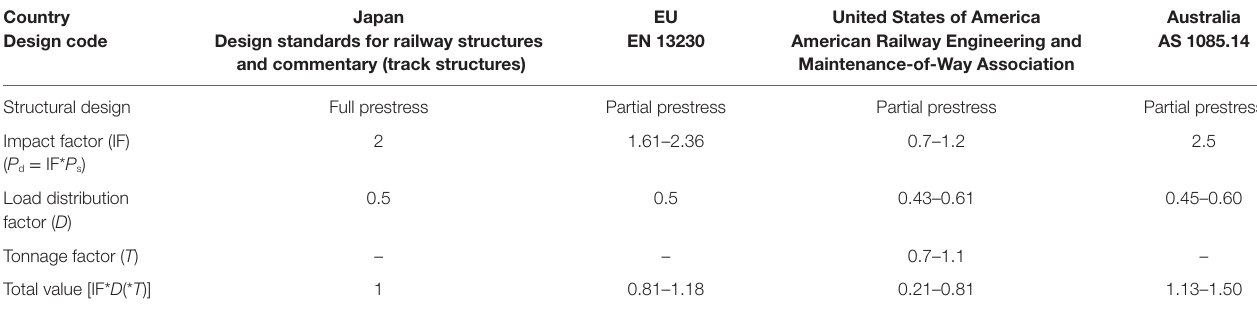
table 1 | Comparison of design methods among countries.